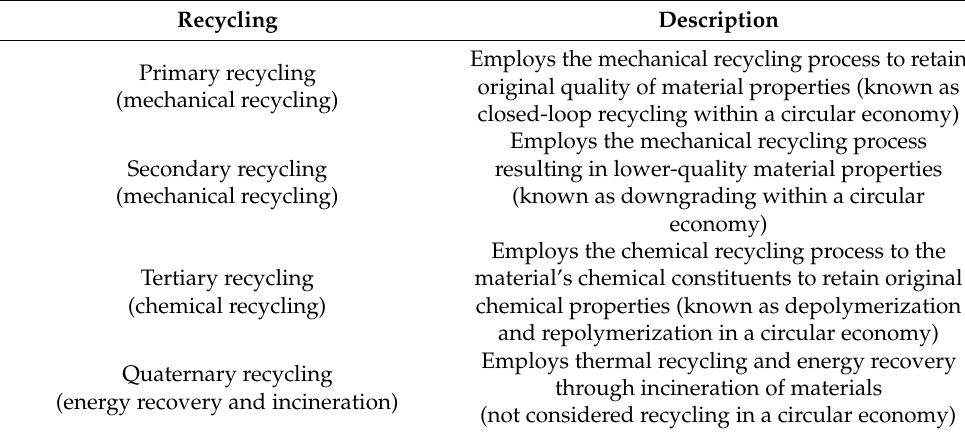
Table 2. Overview of plastic recycling methods